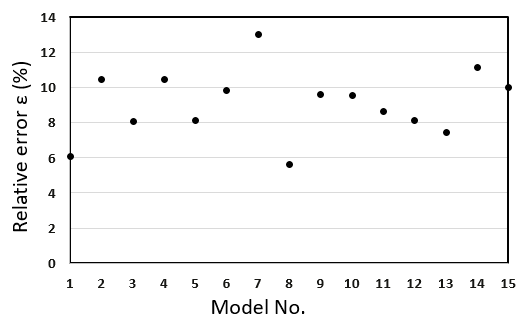
Figure 6. Robustness of fracture modelling in terms of the relative errors on permeability.